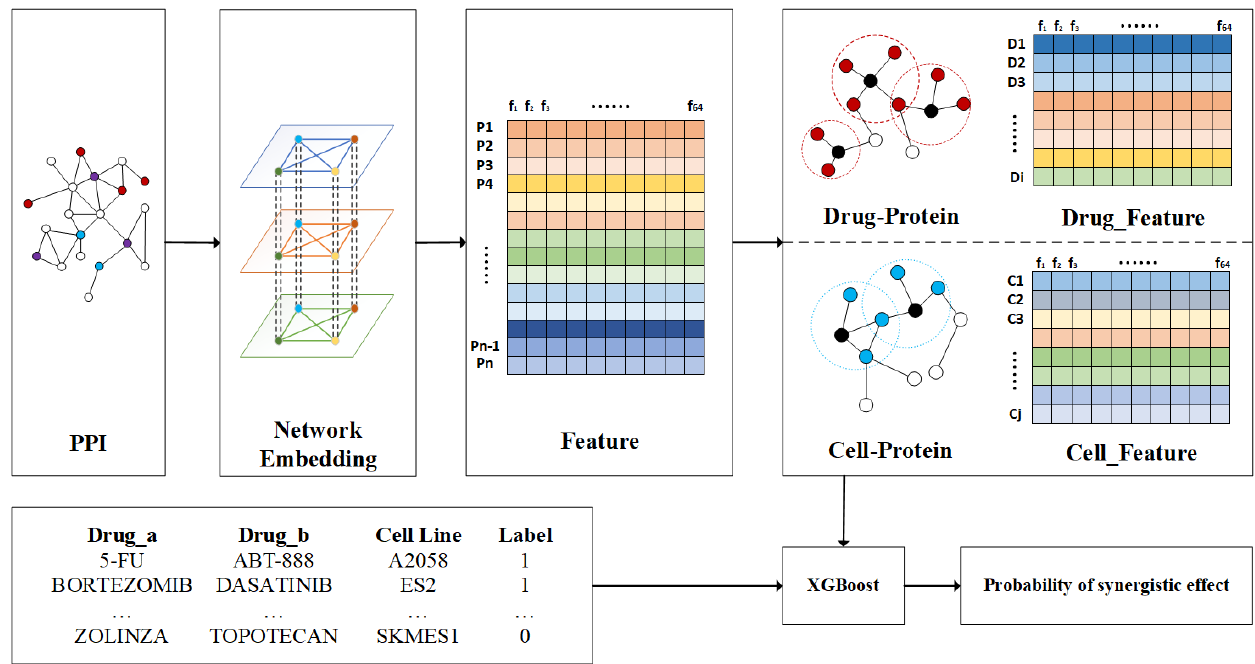
Figure 5. The framework of the NEXGB. The PPI network serves as the input of the model, where red represents the drug target protein, blue is the cell line target protein, and purple is the drug – cell line interaction protein. The struc2vec component perform feature extraction for the protein nodes in the input PPI network. We further obtain the features of drugs and cell lines through the drug – protein and cell – protein relationships. Labels 1 and 0 in the drug – drug – cell line combination matrix indicate synergistic and antagonistic effects, respectively. The drug characteristics and cell line characteristics are then concatenated and input into XGBoost. The output of XGBoost is the combined synergistic probability.